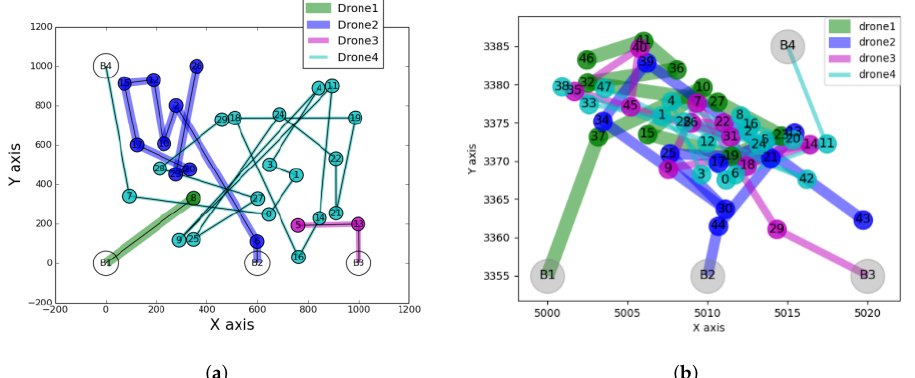
Figure 6. Paths generation when speeds distribution is changed. ( a ) Path generation on a random network; ( b ) Path generation on a real